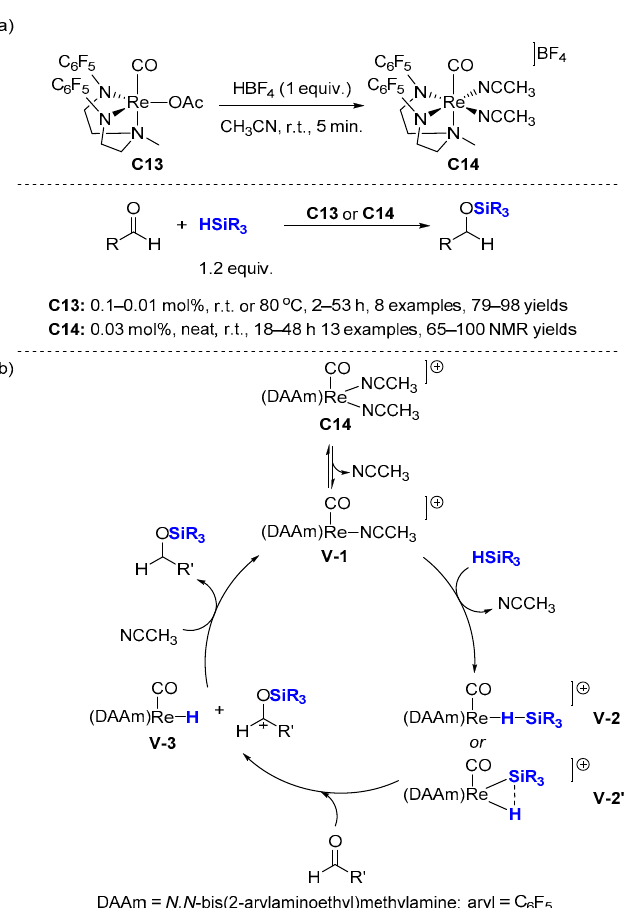
Scheme 7. Cationic rhenium complex catalyzed hydrosilylation of aldehydes. ( a ) Scope of the reaction; ( b ) Proposed